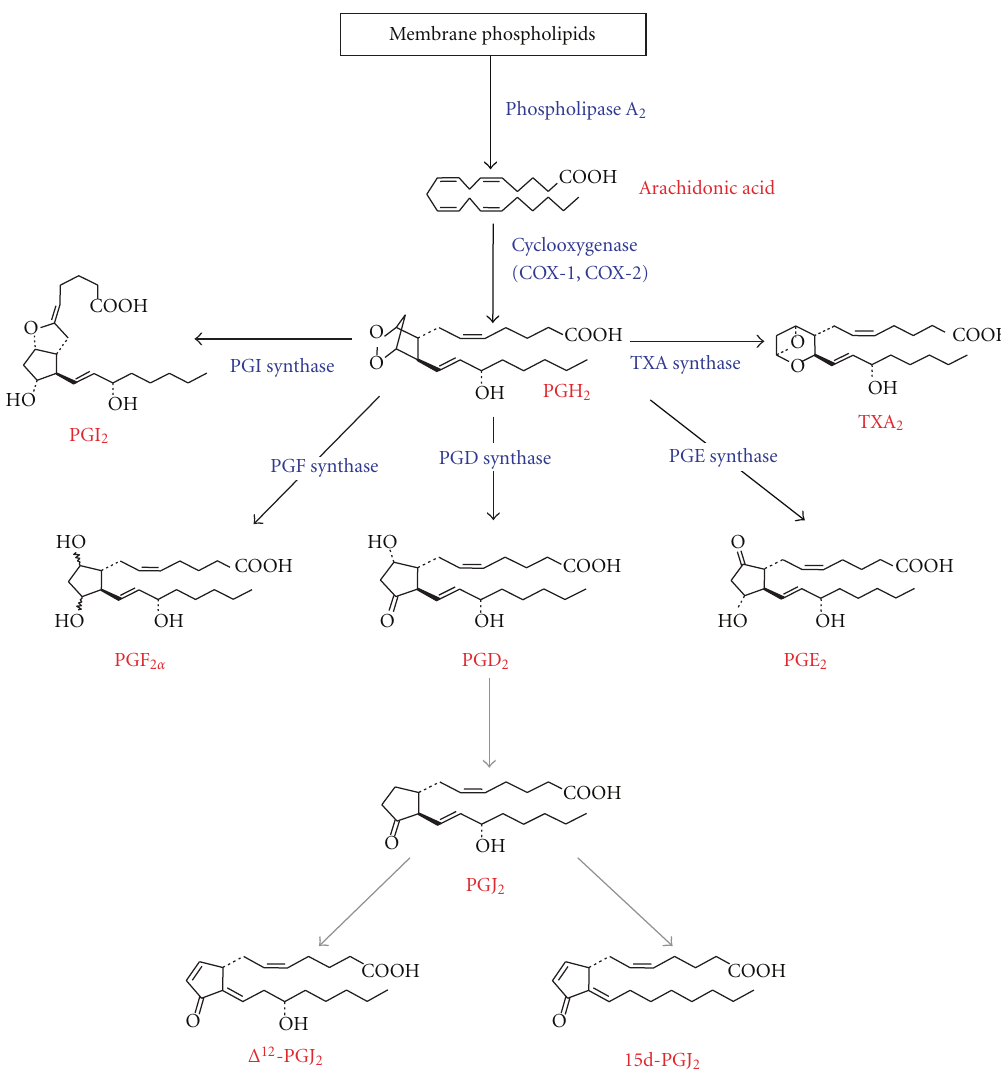
Figure 1: Biosynthetic pathway of prostaglandins. PGJ 2 , Δ 12 -PGJ 2 , and 15d-PGJ 2 are converted from PGD 2 by nonenzymatic dehydrations. Fluprostenol, an FP receptor agonist, clearly reduces the expression of PPAR γ and its target genes [31, 50]. More- over, this Fluprostenol-mediated suppression of the gene expression is cleared by cotreatment with AL8810, an FP receptor antagonist, indicating that PGF 2 α inhibits adipocyte di ff erentiation of 3T3-L1 cells by acting through an FP